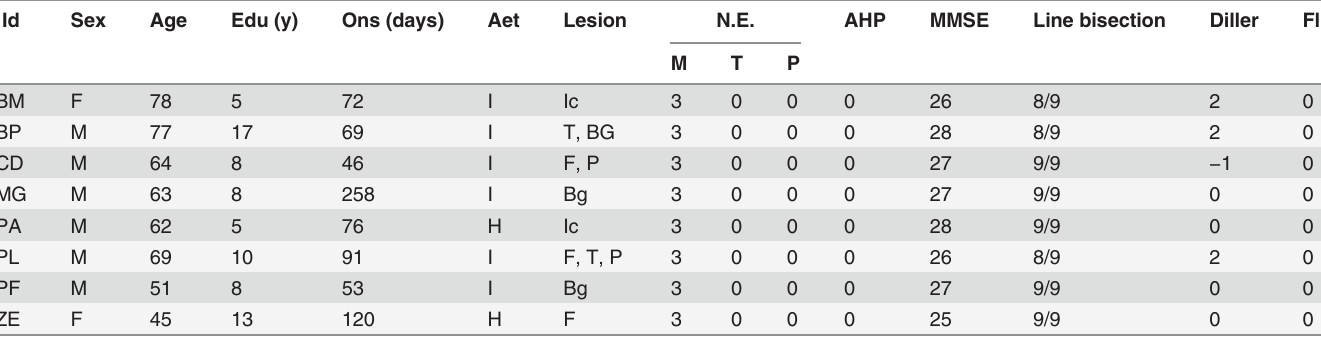
Table 1. Demographical, neurological and neuropsychological data of the HP group.